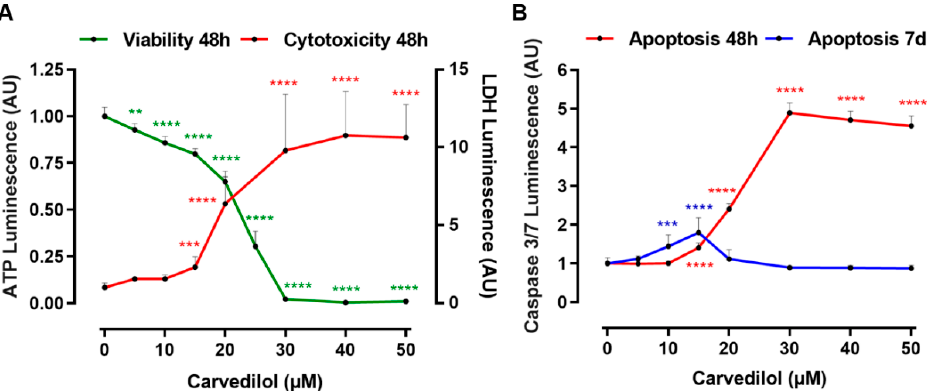
Figure 5. Cytotoxicity of carvedilol and the induction of apoptosis in 3D tumor spheroids. Spheroids were generated from a Mel270 cell line. ( A ) Spheroids were treated with carvedilol at the indicated concentration for 48 h. Spheroid viability was assayed with an ATP luminescence assay. The ATP lu- minescence of the treated spheroids was normalized to the ATP luminescence of the control spheroids (0 µ M carvedilol) and is given in arbitrary units (AU). Representative results from 3 independent experiments are shown. The means SD of n = 8 spheroids for each condition are shown. The cy- totoxicity of carvedilol was assayed with the LDH-Glo cytotoxicity assay. The LDH luminescence was normalized to the LDH luminescence of the control spheroids (0 µ M carvedilol) and is given in arbitrary units (AU). The means ± SD of n = 8 spheroids for each condition are shown. ( B ) Spheroids were treated with carvedilol at the indicated concentration for either 48 h or 7 days. Spheroid apopto- sis was assayed with a caspase 3/7 luminescence assay. The caspase 3/7 luminescence of the treated spheroids was normalized to the luminescence of the control spheroids (0 µ M Carvedilol) and is given in arbitrary units (AU). Representative results from 3 independent experiments are shown. The means ± SD of n = 8 spheroids for each condition are shown. Statistical analysis was performed with one-way ANOVA and Tukey’s multiple comparisons test, and significance levels are indicated at ** p < 0.01, *** p < 0.001, and **** p <